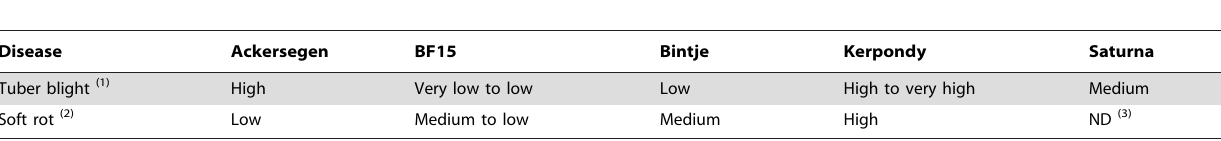
Table 1. Published levels of potato tuber resistance to soft rot ( Pectobacterium atrosepticum ) and late blight ( Phytophthora infestans ) assessed in laboratory